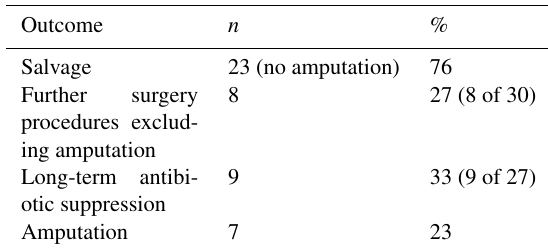
Table 2. Patient outcomes during study period.